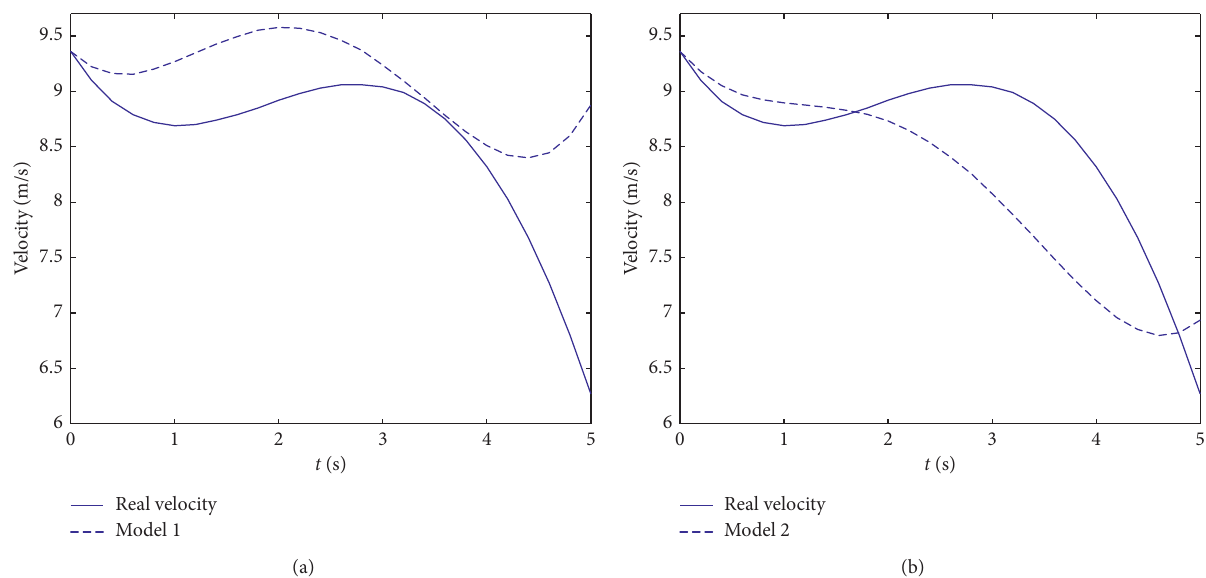
Figure 4: Comparison between simulation curves of improved models and the curve of real velocity: (a) velocity-time curves of improved model 1; (b) velocity-time curves of improved model